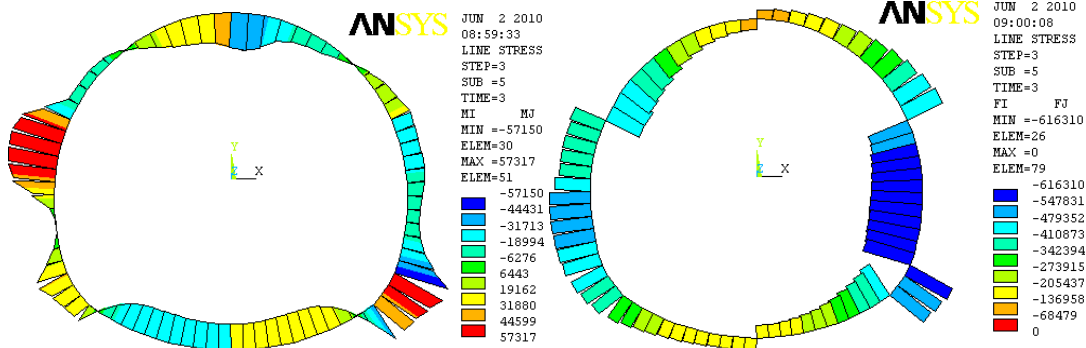
Fig. 4 Supporting axial force and supporting bending moment (/N · m).